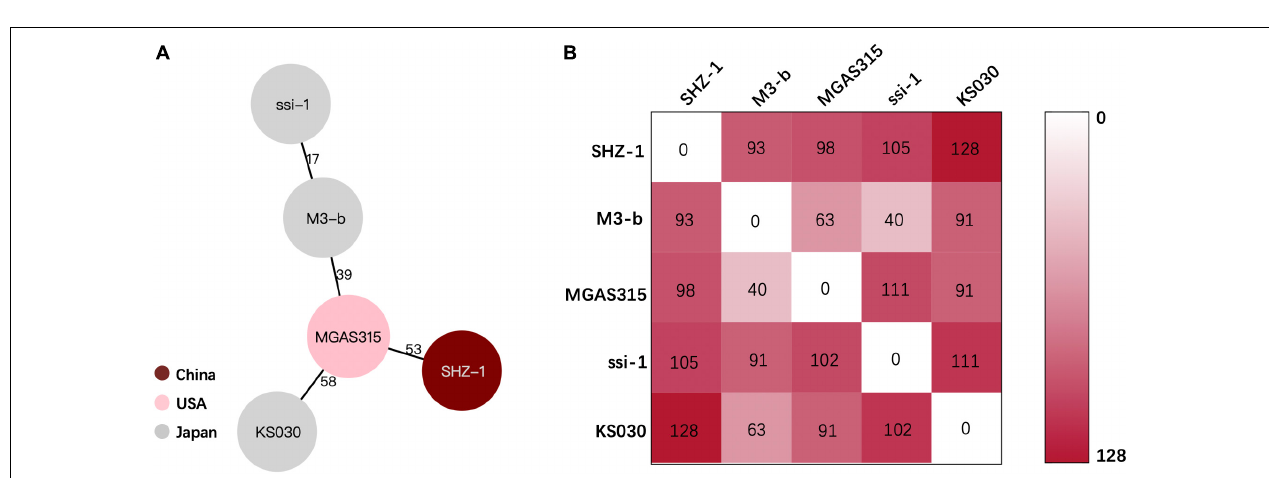
FIGURE 1 | Streptococcus pyogenes strain SHZ-1 infection history and genomic epidemiological analysis. The medical history of SHZ-1 infected patient. Abbreviations in the figure: SSTI, skin and soft tissue infection; LEV, Levofloxacin; VAN, vancomycin; LNZ, linezolid; WBC, white blood cell; N, neutrophils; PCT, procalcitonin; A/C, amoxicillin/clavulanate.